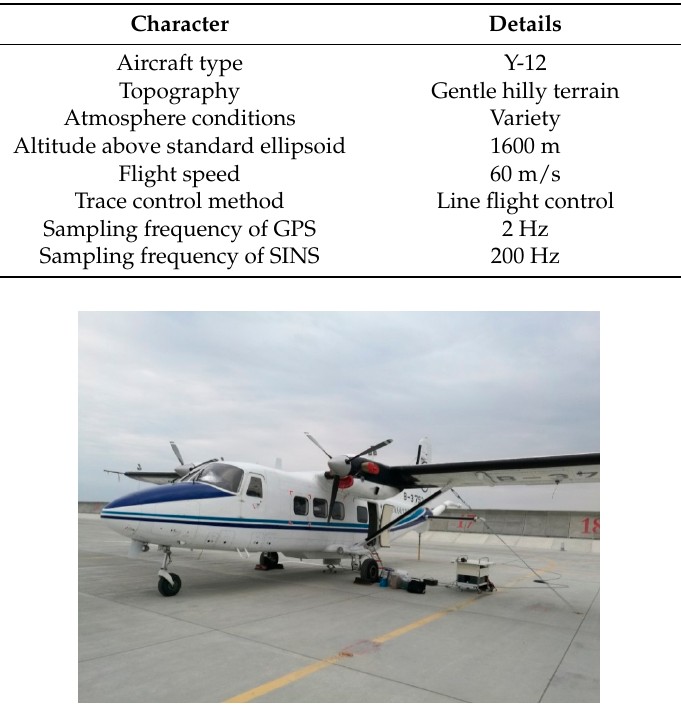
Figure 3. Appearance of aircraft Y-12.